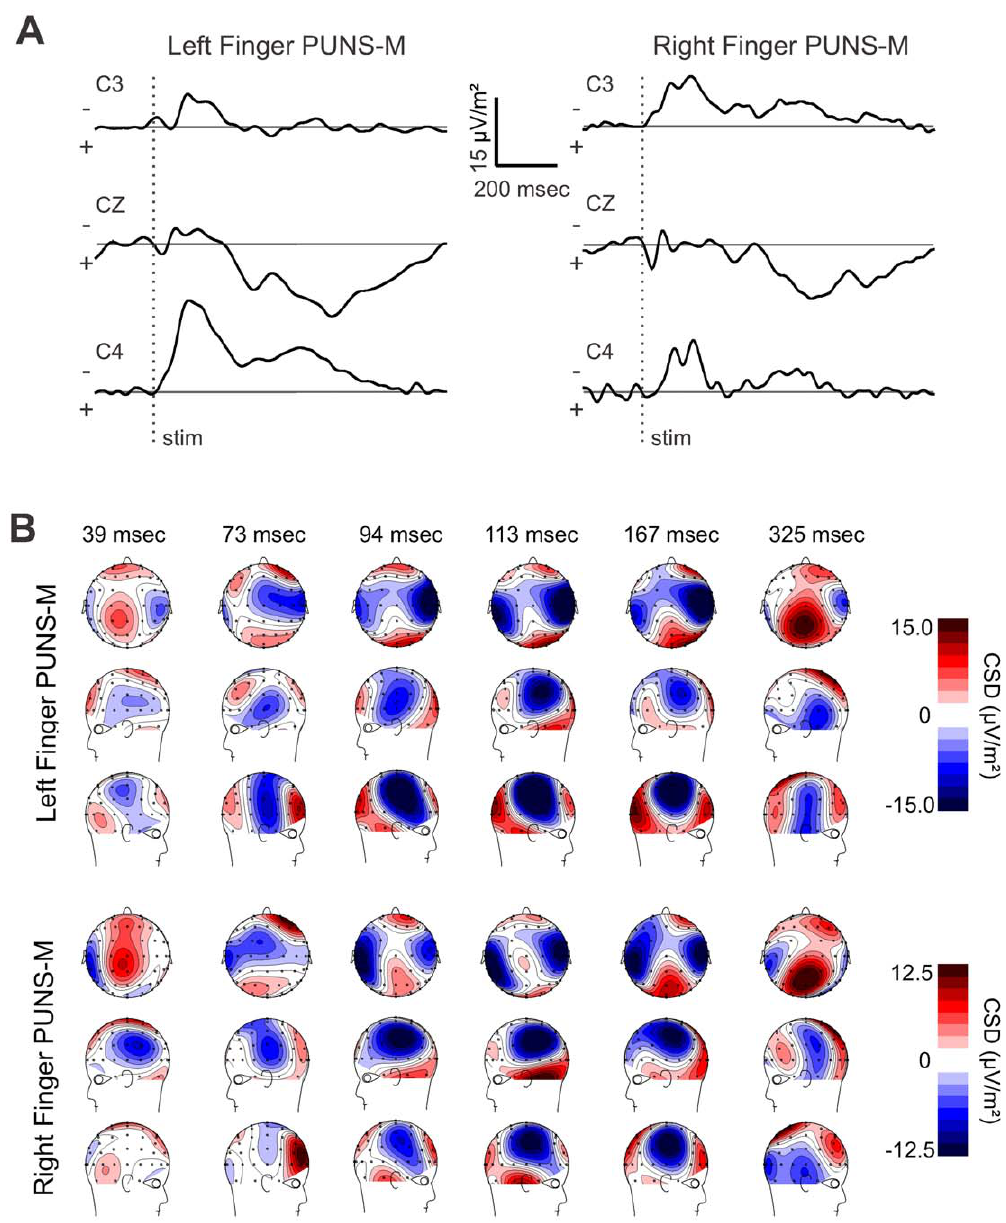
Figure 3. Stimulation of fingertips with PUNS-M reveals dynamic current sources. ( A ) Grand average current source density (CSD) traces obtained from five subjects in response to left ( left ) and right ( right ) fingertip stimulation with PUNS-M waveforms are displayed across time for C3 ( top ), CZ ( middle ), and C4 ( bottom ) electrode sites where ( 2 ) indicates current sink and ( + ) indicates current source. ( B ) Pseudocolor topographic CSD maps corresponding to data illustrated in A for left finger ( top panel ) and right finger ( bottom panel ) stimulation with PUNS-M are illustrated for times following stimulation as indicated.